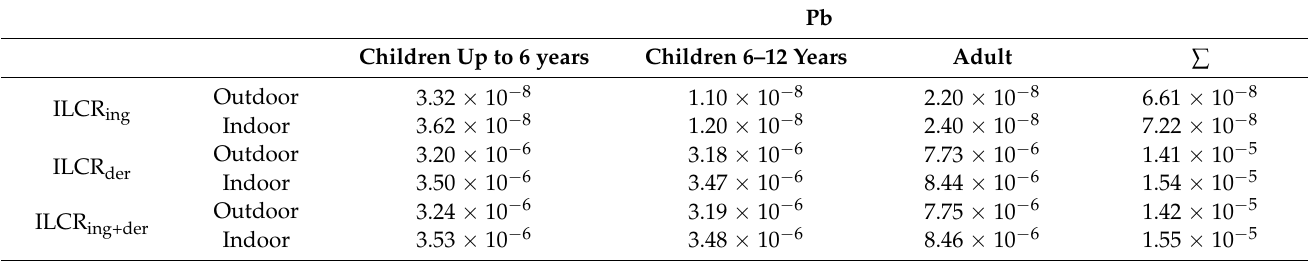
Table 6. Average incremental lifetime cancer risk (ILCR) for Pb of dust in outdoor and indoor